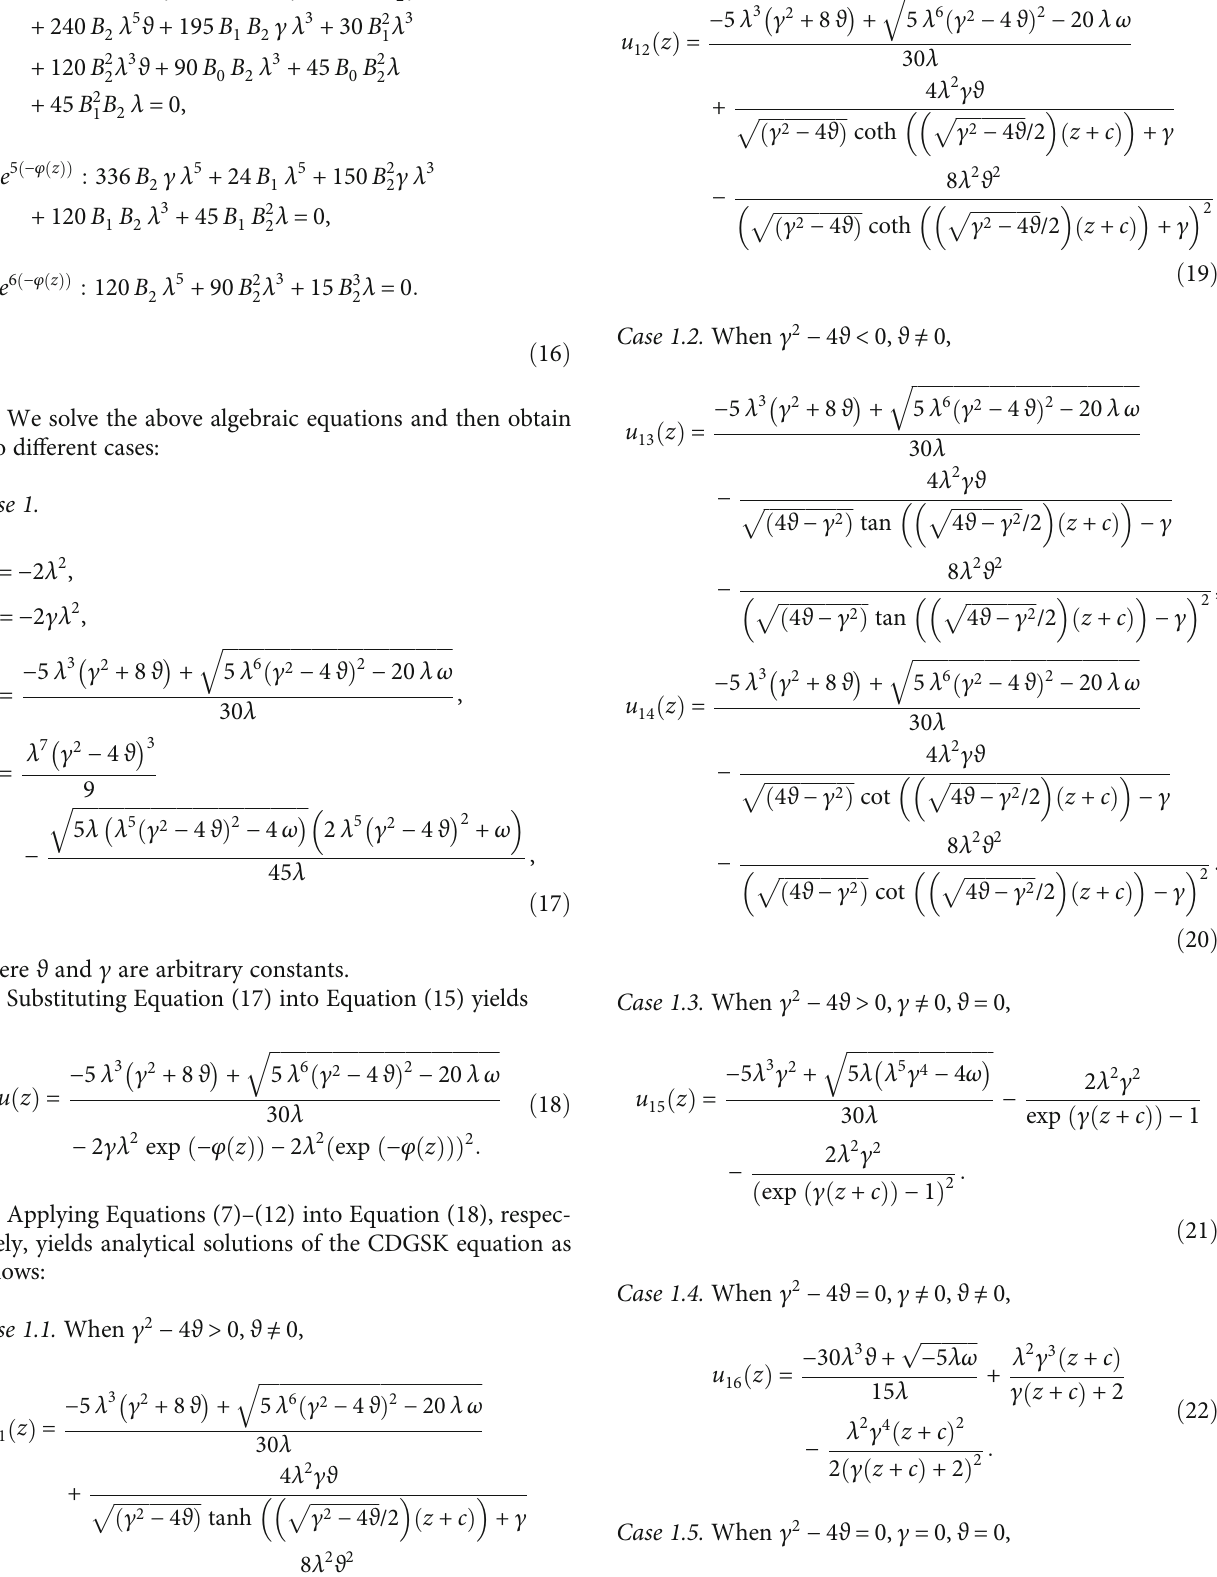
ffiffiffiffiffiffiffiffiffiffiffiffiffiffiffiffiffiffi γ 2 − 4 ϑ ð